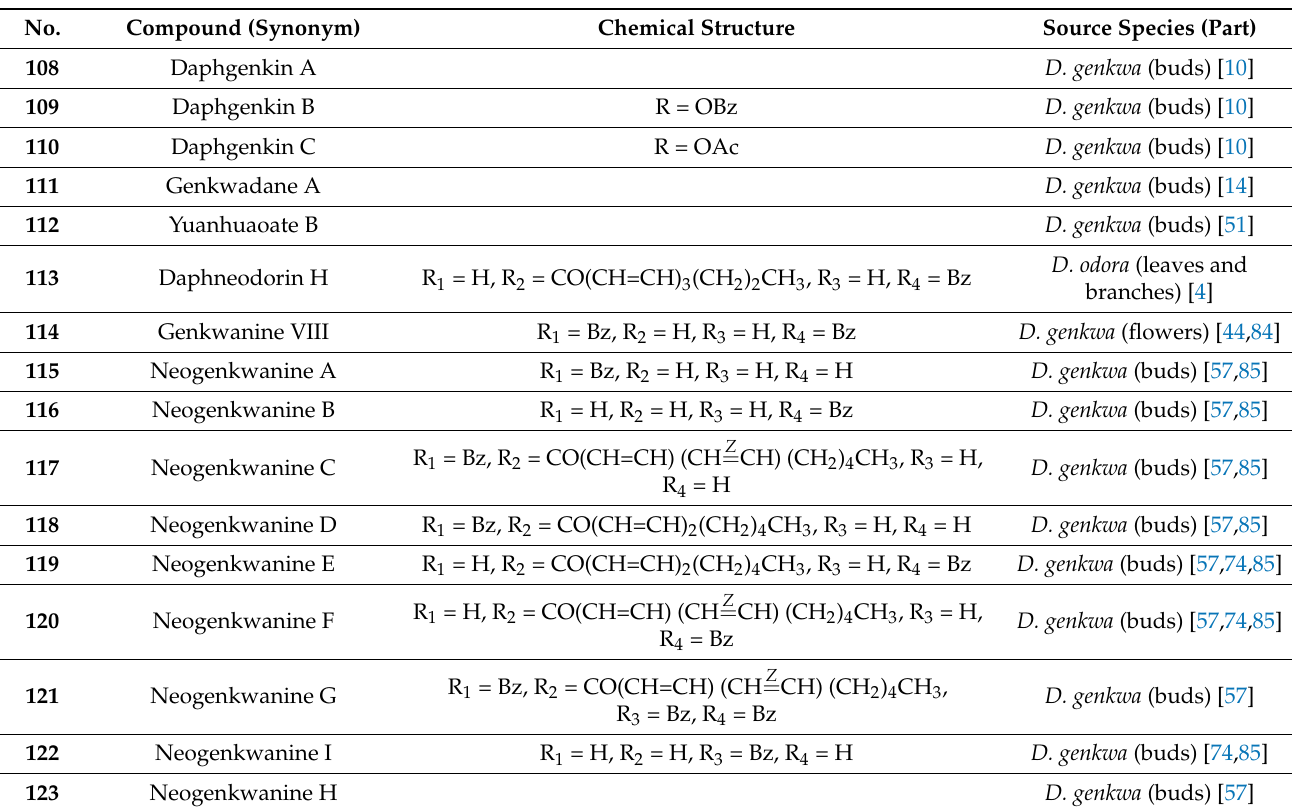
Table 6. Structures and sources of other daphnane diterpenoids from the genus Daphne ( 108 – 123 ).